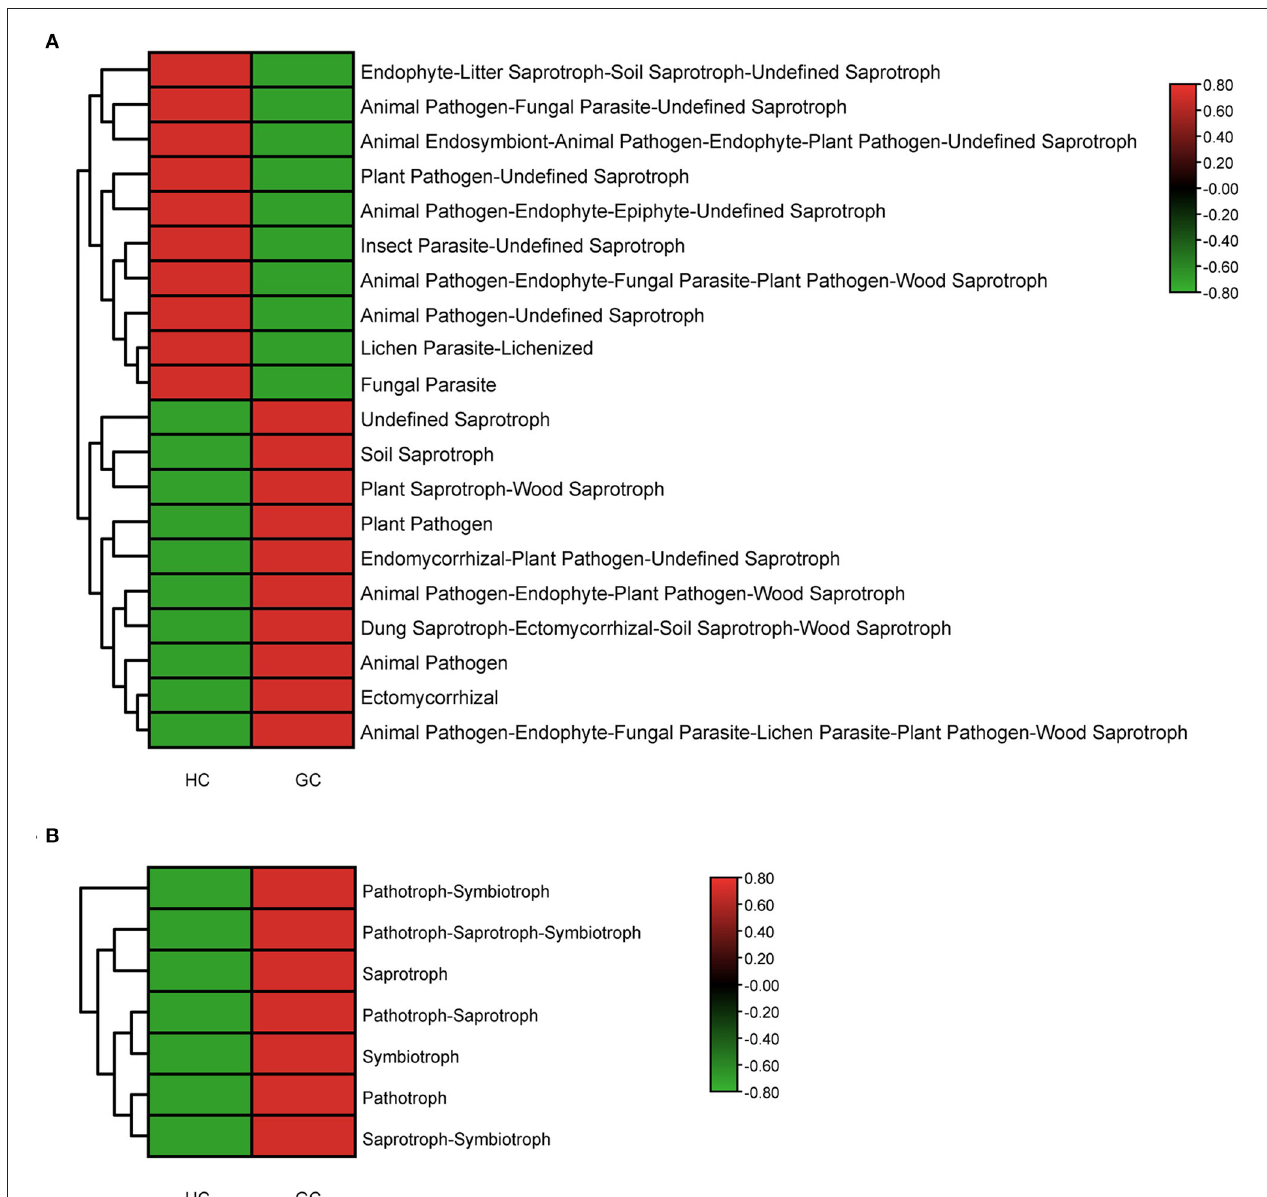
FIGURE 6 | Functional classification predictions. Fungal functional annotations of the two groups were performed by FUNGuild. According to the ways in absorption and utilization of environmental resources, fungi were divided into different categories at the Guild (A) and Trophic (B) levels.